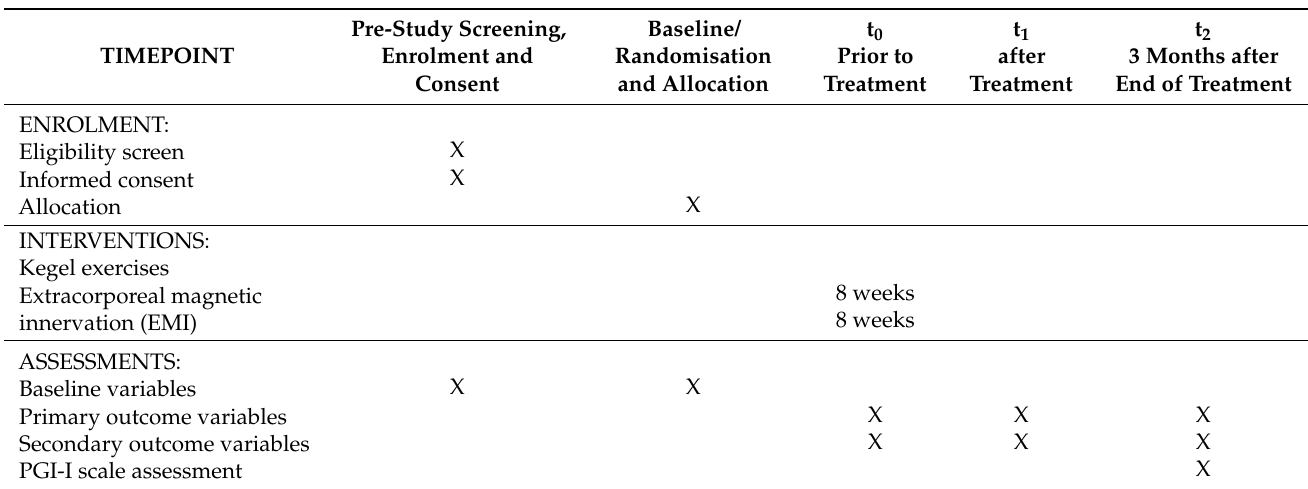
Table 1. Time schedule of enrolment, interventions, assessments, and visits for